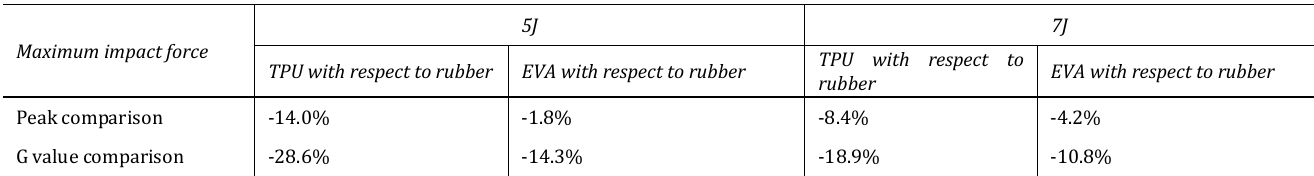
Table 2: Decay rate of different materials under different impact